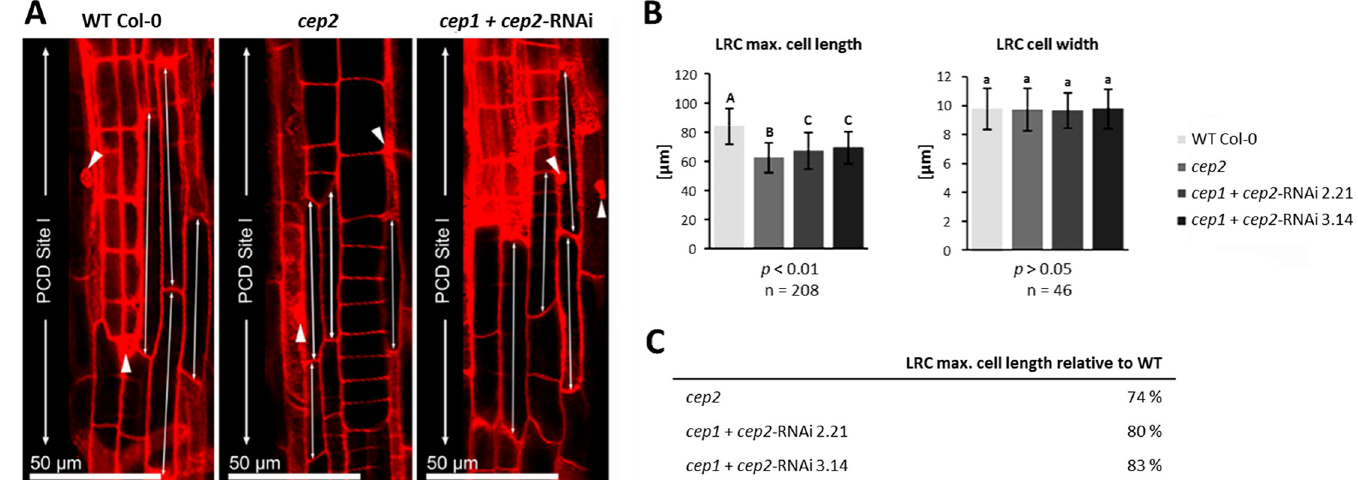
Fig 4. CEP2 loss of function results in shortening the longest cells of the lateral root cap (LRC) at the level of the PCD site I. The residual CEP2 activity in cep1 cep2 double ko/kd mutants ( cep1 + cep2- RNAi)results in prolonged LRC cells as compared to cep2 ko mutants, but shorter as compared to LRC cells in WT plants. (A) 7 days old seedlings of WT, cep2 ko and cep1 cep2 double ko/kd mutants ( cep1 + cep2- RNAi) were stained with propidium iodide and analyzed by CLSM (single pictures, 400-fold magnification). The 3–5 longer most cells of the LRC at the level of the PCD site I (double arrow) are compared. Nuclei stained with propidium iodide are marked (arrow heads) indicating cells approaching PCD since their cell membranes become permeable resulting in propidium iodide stained nuclei in addition to the stained cell wall. (B) Comparison of the length (left) and the width (right) of the 3–5 longer most LRC cells in 7 days old seedlings of WT plants with cep2 ko and cep1 cep2 double ko/kd mutants ( cep1 + cep2- RNAi;lines 2.21 and 3.14) mutants. Columns are marked with different letters indicating statistically different groups for LRC cell length ( p < 0.001) or with similar letters indicating groups not statistically different for LRC cell width ( p > 0.05) according to the ANOVA-and Duncan test. Data represent the respective means of 208 plants in three independent experiments (biological replica) each comprising 15 seedlings per line (experiment 1 and 2, each) or 16 plants (experiment 3) per genotype resulting in 208 longer most LRC cells (3–5 cells per LRC) evaluated for the cell length and 46 LRC cells evaluated for the cell width. (C) LRC cell length expressed as percentage of WT